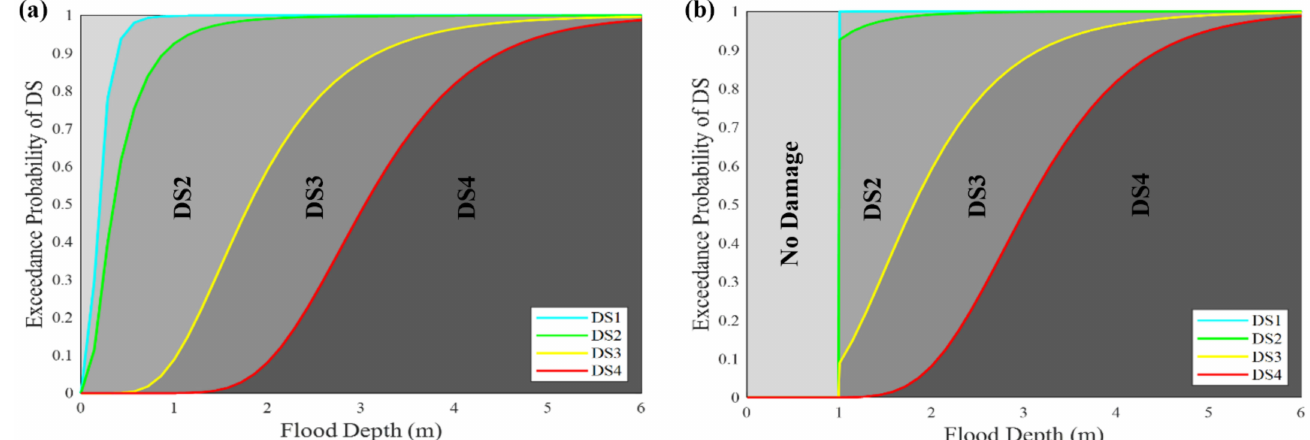
Figure 7. Fragility functions with and without flood barrier with a height of 1.0 m for a one-story multi-family residential building (F2): ( a ) Fragility curves without using a flood barrier; ( b ) fragility curves with the 1.0 m flood